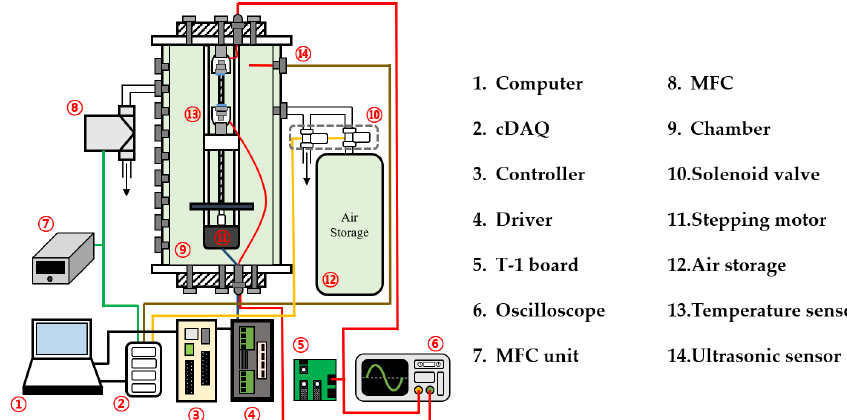
Figure 1. Schematic diagram of experimental equipment.